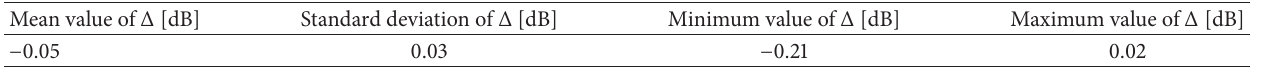
Figure 8: Relationship between 𝐴 ∗ dB and V for different 𝑘 𝑛 values and different 𝜉 𝑛 values: 0.05% (a), 0.1% (b), 0.5% (c), and 1% (d). The + are the points related to the case of V > 1 calculated using (29), (19), and (17), which are then interpolated by fourth-order polynomials (solid curves). The ∗ are the points related to the case of V < 1 calculated again using (29), (19), and (17), which are then interpolated by fourth-order polynomials (solid curves). Table 2: Results of the Monte Carlo simulations for the case 𝑙 ̸= 1 and V = 1 .